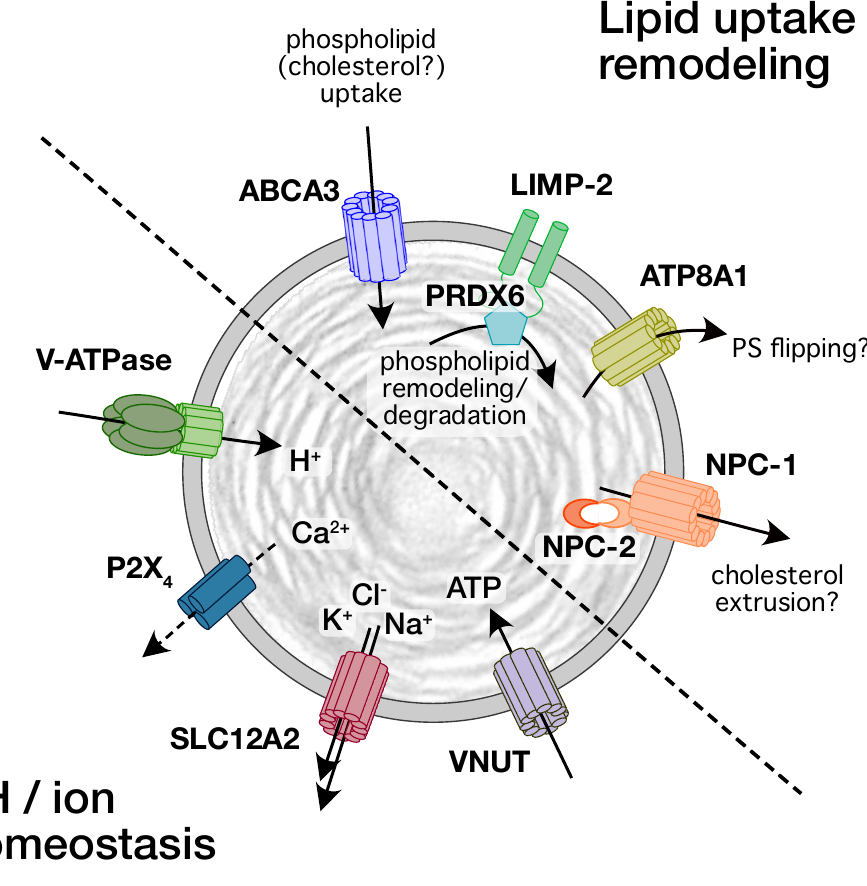
Figure 1. Schematic representation of transporters and channels identified on LBs and their proposed function for lipid and pH/ion